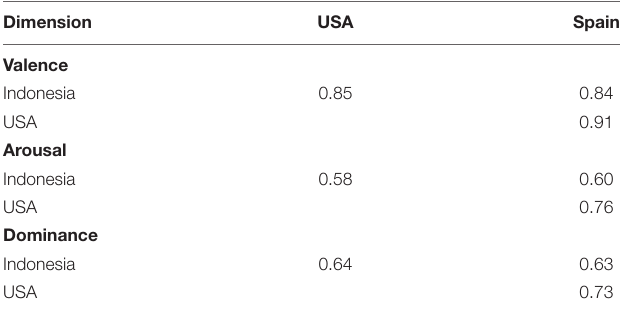
TABLE 3 | Cross-cultural correlational results (collapsing